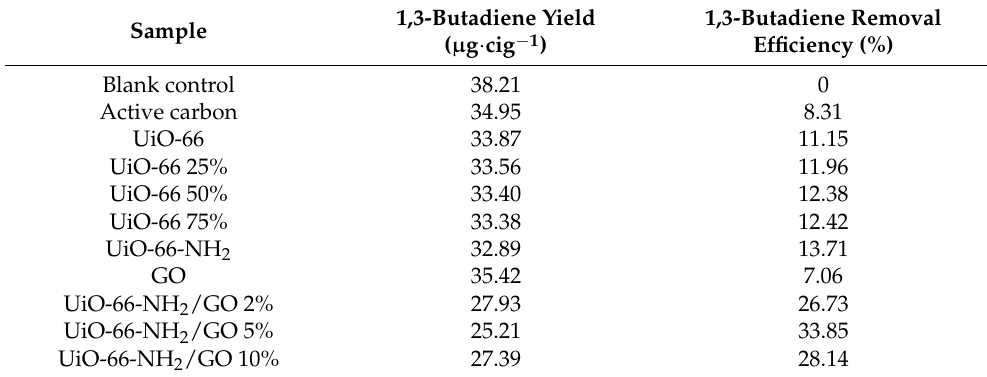
Table 4. 1,3-Butadiene removal efficiency in cigarette